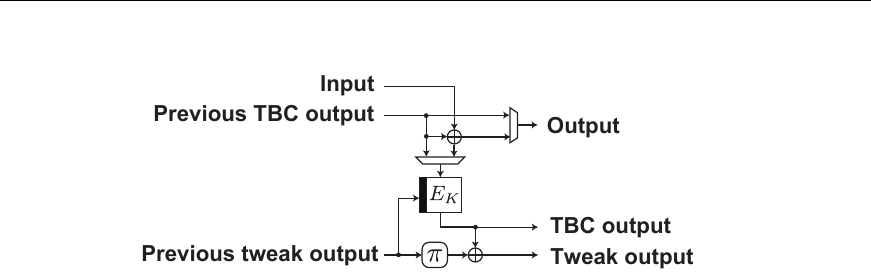
Figure 15: The operational unit that covers all the block-wise operations in LM-DAE smaller block size, which becomes × 3 in TI [NSS20], while the tweakey part becomes × 2 only. The non-deterministic schemes can have smaller register sizes (e.g., PFB’s 768 bits and PFB_Plus’ 704 bits) because the tweak storing the public nonce needs no SCA